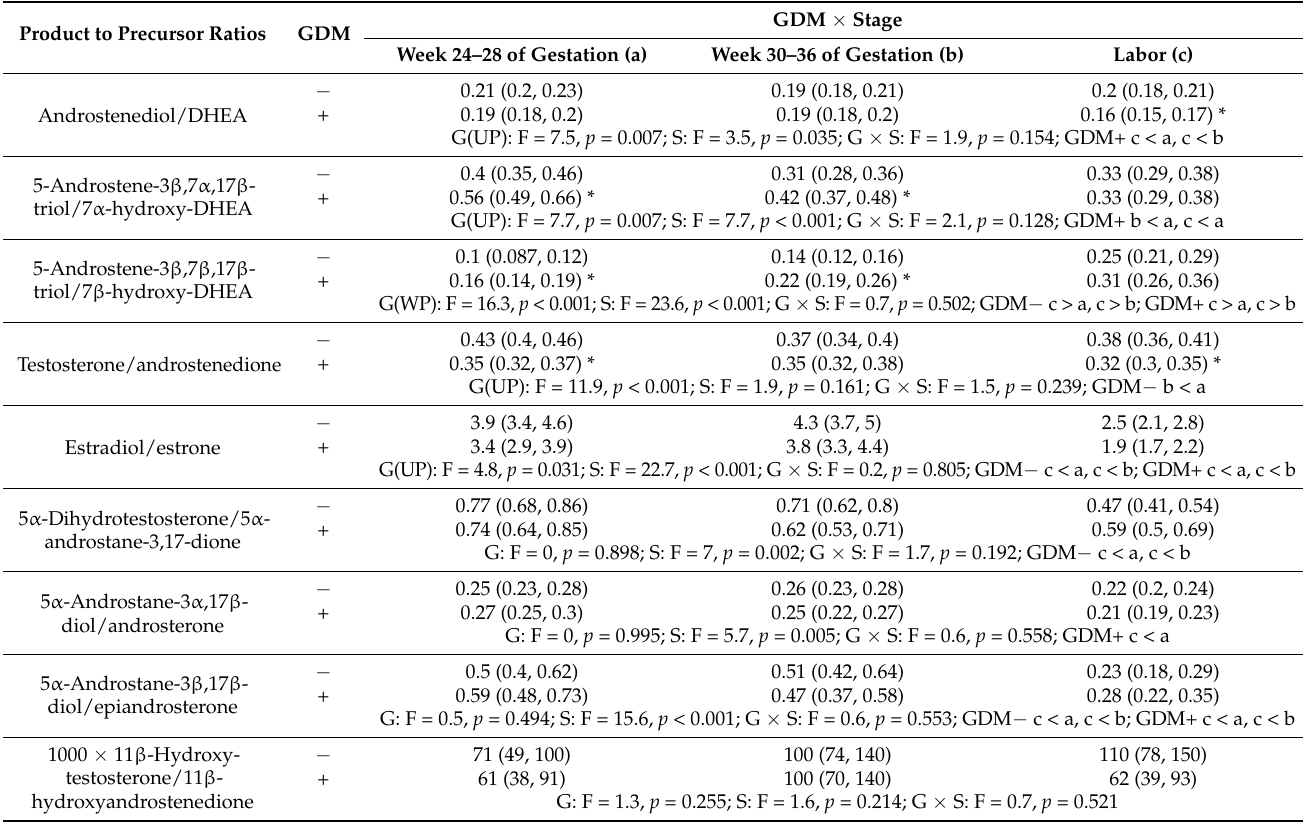
Table 5. Profiles of product to precursor ratios that may reflect the balance between 17 β -hydroxy- and 17-oxo-steroids in the GDM − and GDM+ groups from week 24 of gestation to